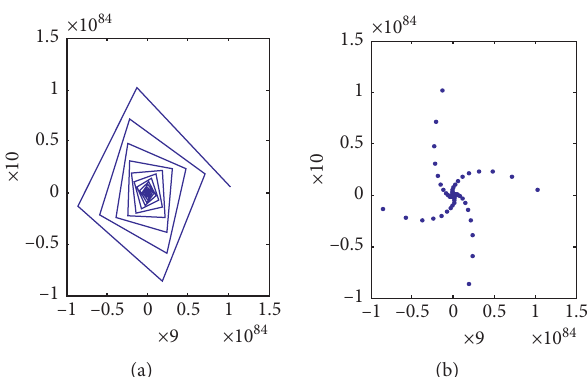
Figure 29: ω � 273 and k � 0with the Coulomb model when t ∈ 0 . 05 0 . 0581 􏼂 􏼃 . (a) Phase trajectories. (b) Poincare w